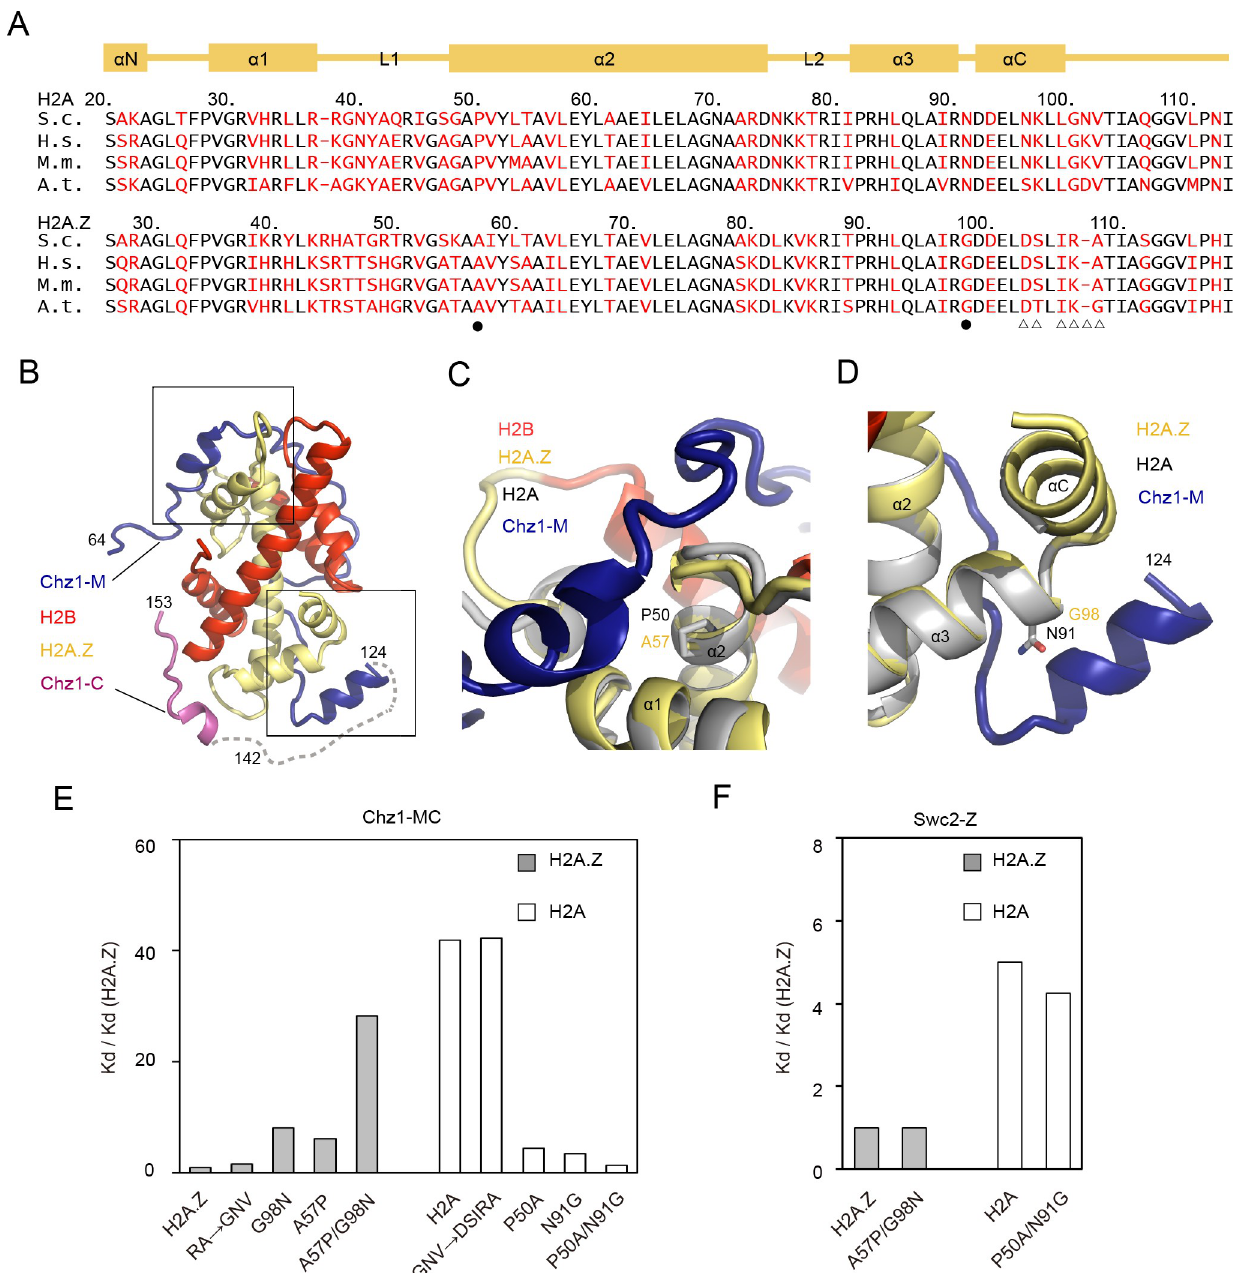
Fig 3. H2A.Z residues with key roles for preferential recognition of Chz1. (A) Schematic view of aligned H2A.Z and H2A. Shown on the top is a schematic view of the secondary structure of both histones. H2A.Z-specific residues and their H2A counterparts are colored in red. Residues interchanged for ITC analysis are highlighted with dots or triangles. Black dots highlight H2A.Z residues playing central roles in preferential recognition of Chz1. (B) Structural model of Chz1 in complex with H2A.Z-H2B. Structure of Chz1-C complex is superimposed with the structure of Chz1-M complex (PDB 2JSS). The dotted line stands for Chz1 residues 125–141, which are not visible in both structures. Blue: Chz1-M; magenta: Chz1-C; red: H2B; yellow: H2A.Z. (C) Close view of the binding interface between H2A.Z α 2-helix and Chz1 α N-helix. H2A.Z residue A57 and its H2A counterpart P50 are colored in yellow and gray. H2A-H2B structure from nucleosome (PDB: 1ID3) is superimposed for comparison. (D) Close view of the binding interface between H2A.Z α 3-helix and Chz1 α C-helix. H2A.Z residue G98 and its H2A counterpart N91 are colored in yellow and gray. H2A-H2B structure from nucleosome (PDB: 1ID3) is superimposed for comparison. (E) Effect of H2A.Z-H2A and H2A-H2A.Z interchanges on Chz1 recognition by ITC analysis. The underlying data can be found in S1 Data. (F) ITC analysis showing the effect of H2A.Z mutant A57G/G98N and H2A residues P50G/N91G on recognition of H2A.Z- chaperone Swc2. The underlying data can be found in S1 Data. A . t ., Arabidopsis thaliana ; Chz1, chaperone for H2A.Z-H2B; Chz1-C, C-terminal region of